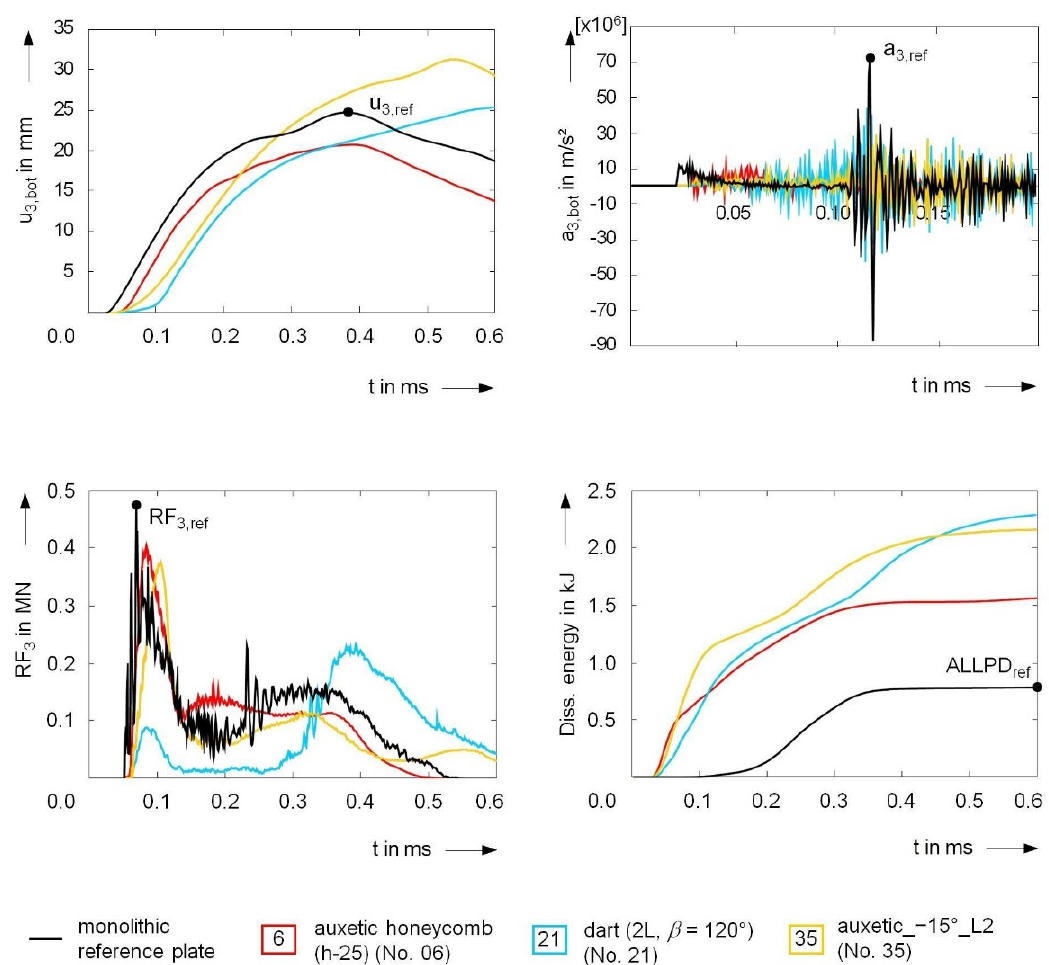
Figure 18. Temporal evolution of the relevant mechanical parameters during blast loading.